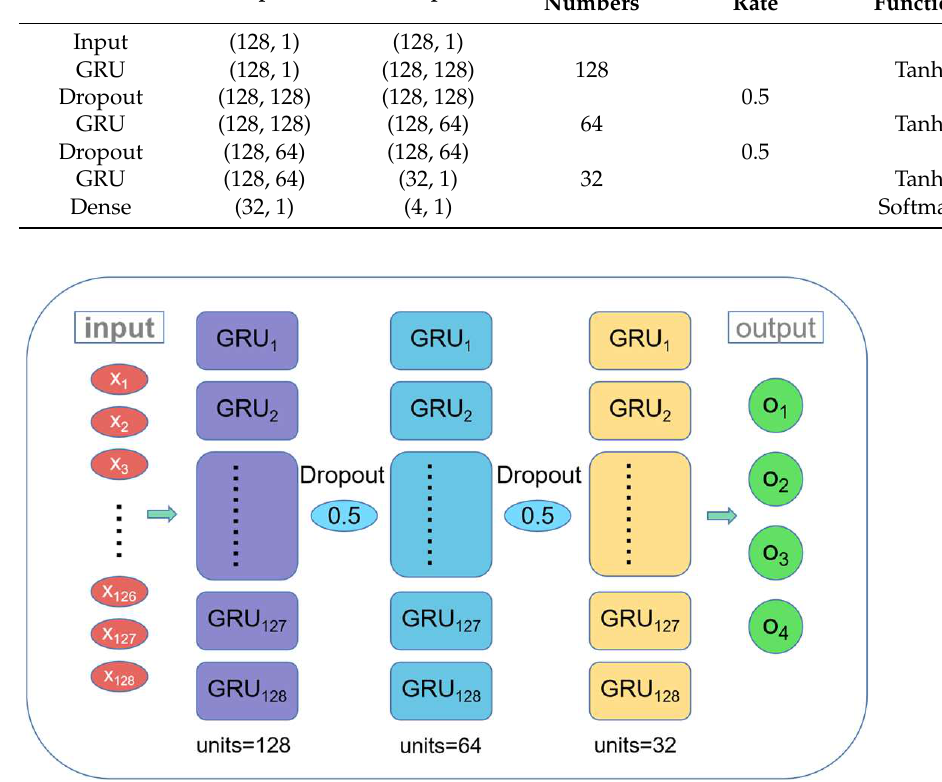
Figure 5. The structure of single-fault (cylinder) diagnosis network. Table 4. Structural parameters of single-fault (cylinder) diagnosis network.